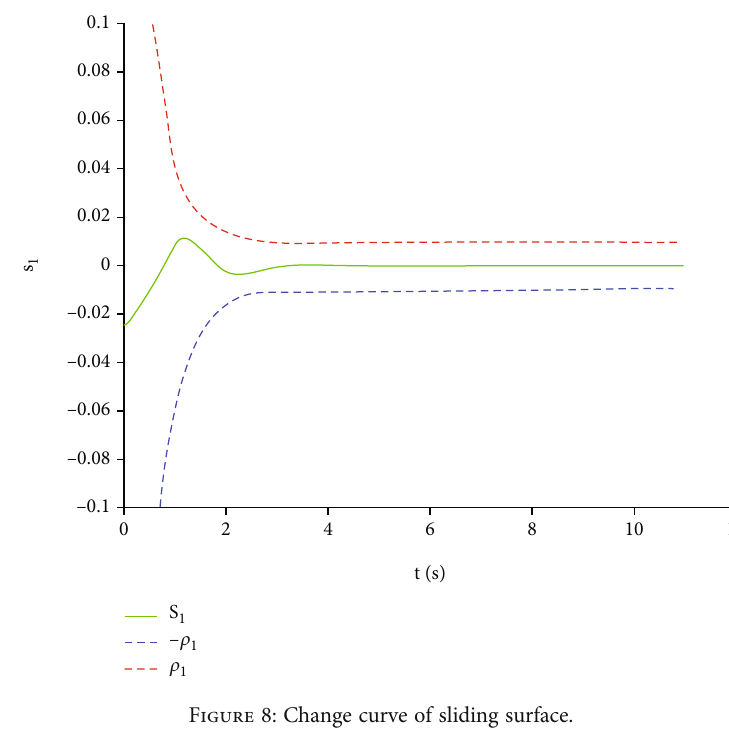
Figure 8: Change curve of sliding